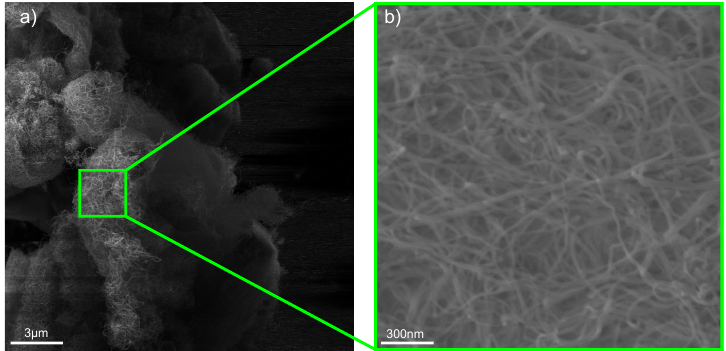
Figure A5. SEM images for CNTP at magnifications of ( a ) 10k and ( b ) 150k.